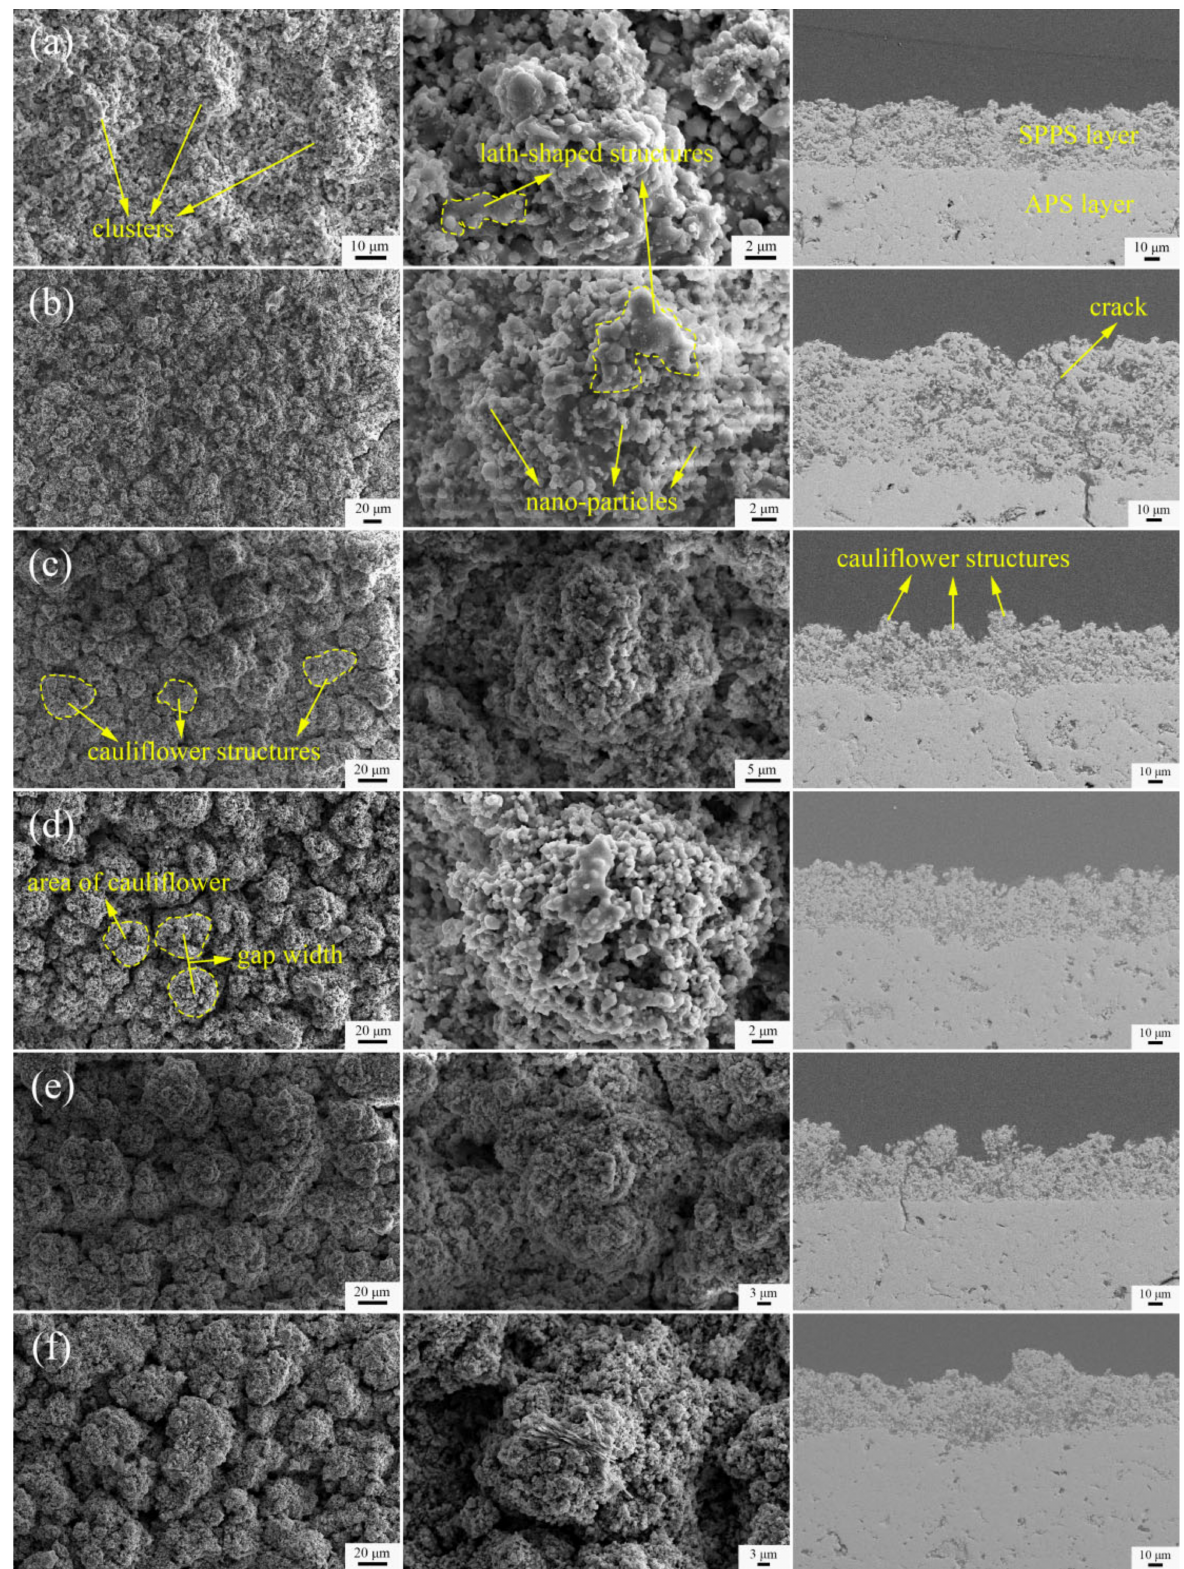
Figure 3. SEM images of sample surface and section: ( a ) group 1; ( b ) group 2; ( c ) group 3; ( d ) group 4; ( e ) group 5; ( f ) group